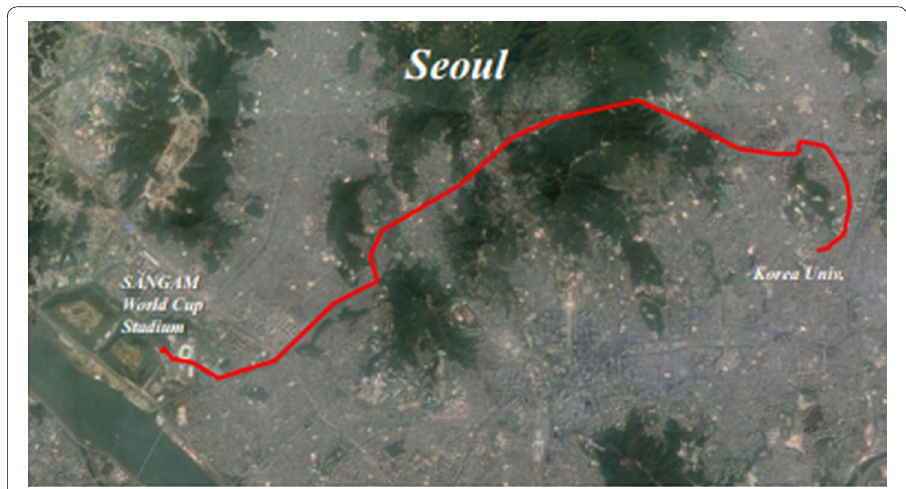
Fig. 1 Drive loop location used for security dataset